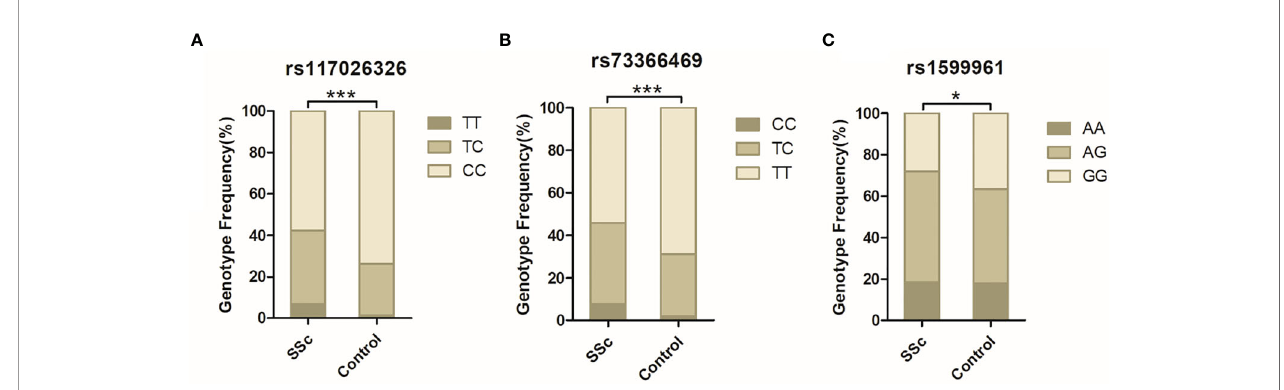
FIGURE 1 | The genotype distributions of the three signi fi cant SNPs [ (A) rs117026326, (B) rs73366469, and (C) rs1599961] in the patients with SSc and healthy controls are summarized. *** P < 0.001. * P <